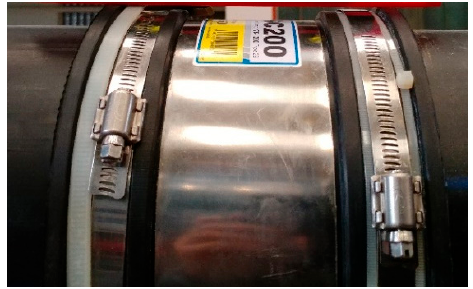
Figure 2. Flexseal Couplings SC200 reinforcement.